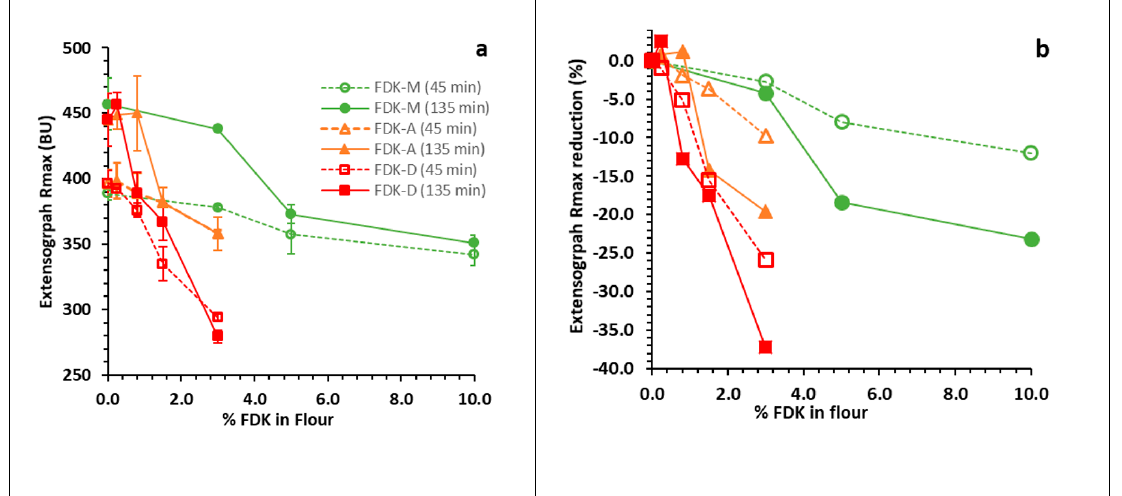
Figure 1. Absolute ( a ) and relative ( b ) reduction of Extensograph Rmax between 45 min (abbreviated) and 135 min (standard) tests with increasing FDK content. Rmax typically increases between 45 min and 135 min (( a ), broken versus solid lines) as re-polymerization occurs during dough development, increasing resistance and decreasing extensibility. Protease damage is evident by the convergence of the broken (45 min) and solid (135 min) lines, indicating reduced increase in Rmax with increasing Rmax.